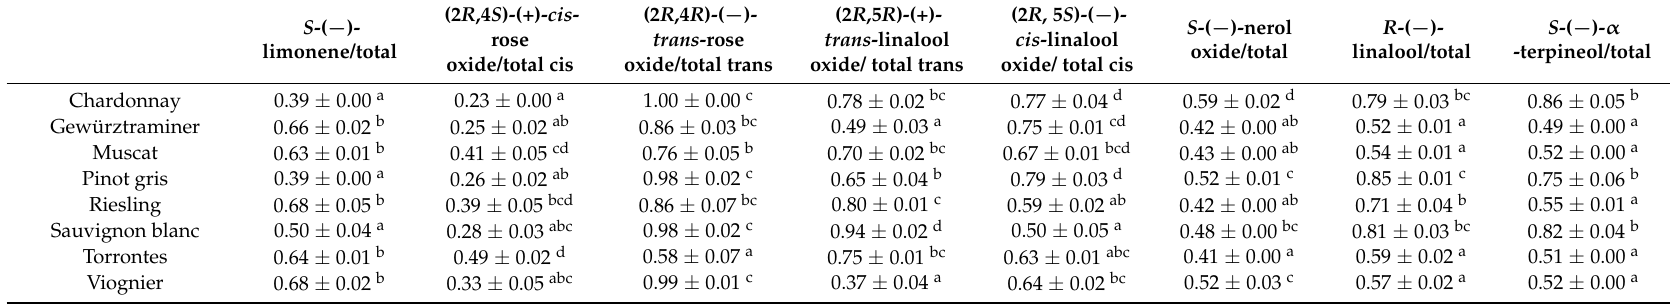
Table 3. Enantiomer fractions (EFs) * ± standard error found in different varietal wines determined by ANOVA and Tukey’s HSD ( α = 0.05) ** . (2 R ,4 S )-(+)- cis - S -( − )- rose limonene/total oxide/total cis